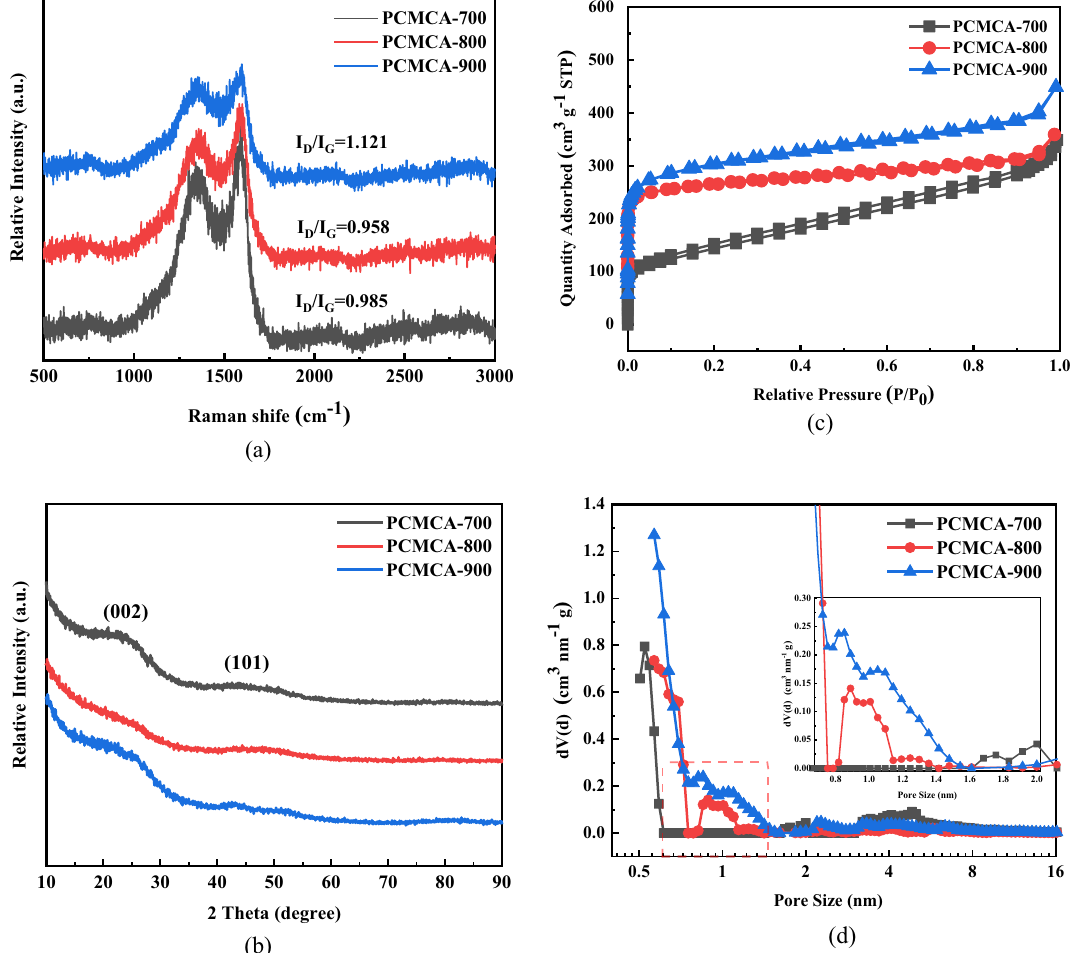
Fig. 2 a Raman curves; b XRD profiles; c N 2 adsorption/desorption isotherms and d pore size distribution curves of the prepared